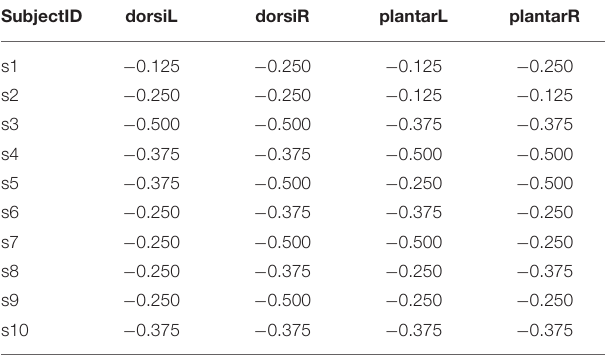
TABLE 2 | Single-trial detection performance (latency) for each subject with the combination of MRCPs and